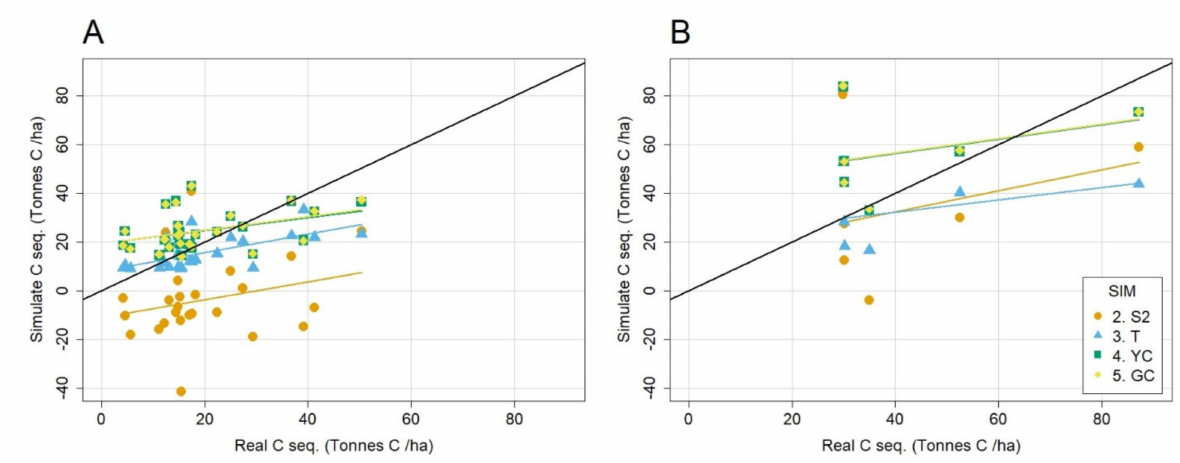
Figure 4. Carbon sequestration at six ( A ) and 12 ( B ) years of projection in second-growth RORACO forests in southern Chile for each simulation model. Solid black lines represented the one-to-one line between observed and predicted values. Solid color lines are the fitted regression for each of the simulations S2, T, YC, and GC (see text for